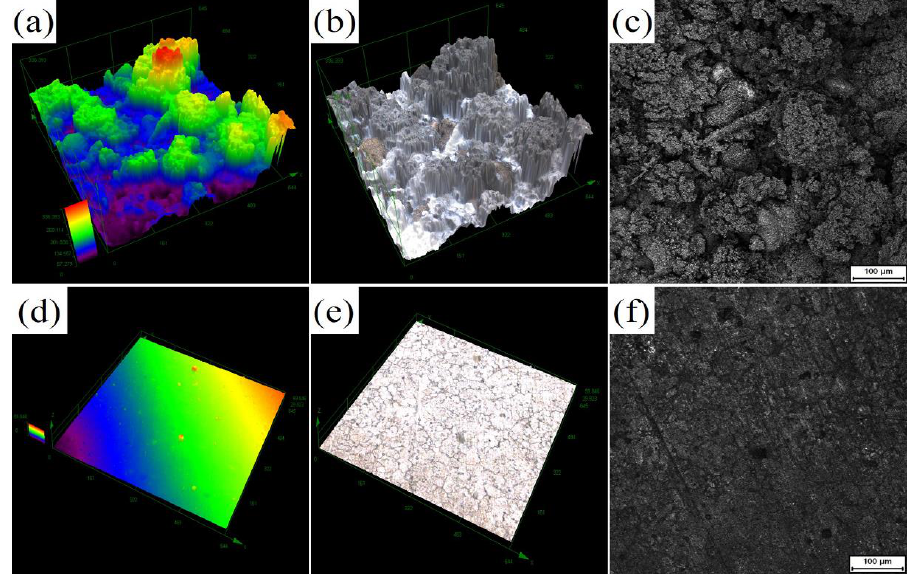
Figure 9. The surface microscopic images of alloys after multi-stage oxidation in air: ( a )-3D, ( b )-3D and ( c ) of AZX801; ( d )-3D, ( e )-3D and ( f ) of AZX802.The surface of AZX801 after oxidation is rough and inhomogeneous with some porous and dark positions scattered on. While the surface of AZX802 after oxidation is smooth and homogeneous just with few oxide particles which the grain boundary can even be seen.